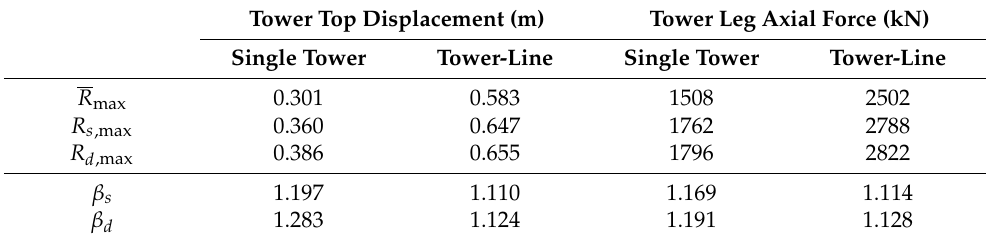
Table 2. Dynamic amplification factor of a transmission tower under downburst.